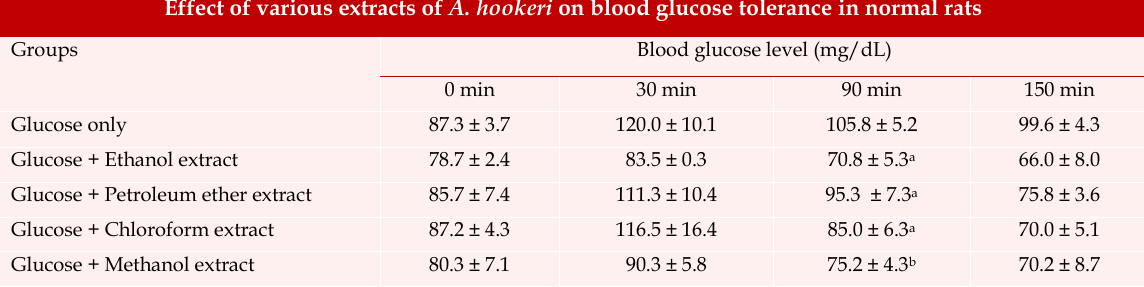
Effect of various extracts of A. hookeri on blood glucose tolerance in normal rats Groups Blood glucose level 0 min Glucose only Glucose + Ethanol extract Glucose + Petroleum ether extract Glucose + Chloroform extract Glucose + Methanol extract The values are expressed as mean ± SEM; a p<0.01 when compared to control; b p>0.05 when compared to control